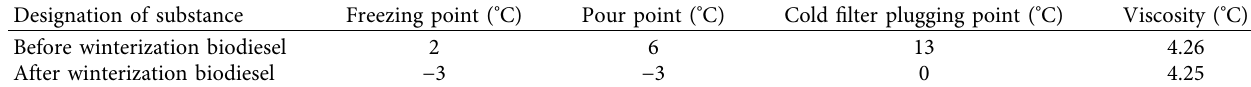
Table 3: Cold flow properties of shea butter biodiesel.